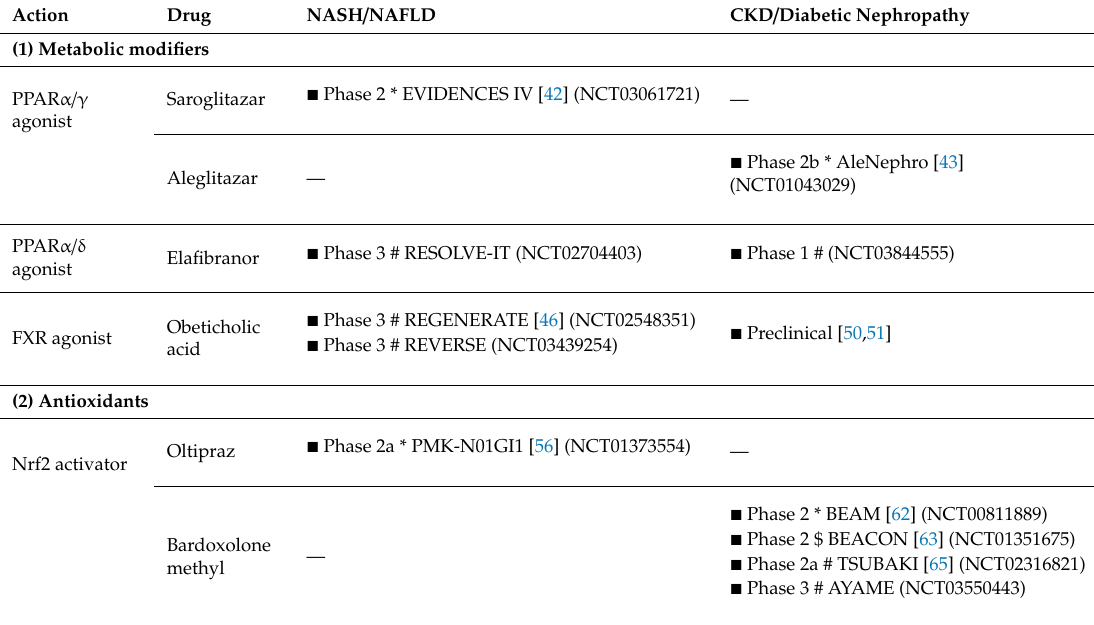
Table 1. Common drug pipelines for NASH / NAFLD and CKD / diabetic